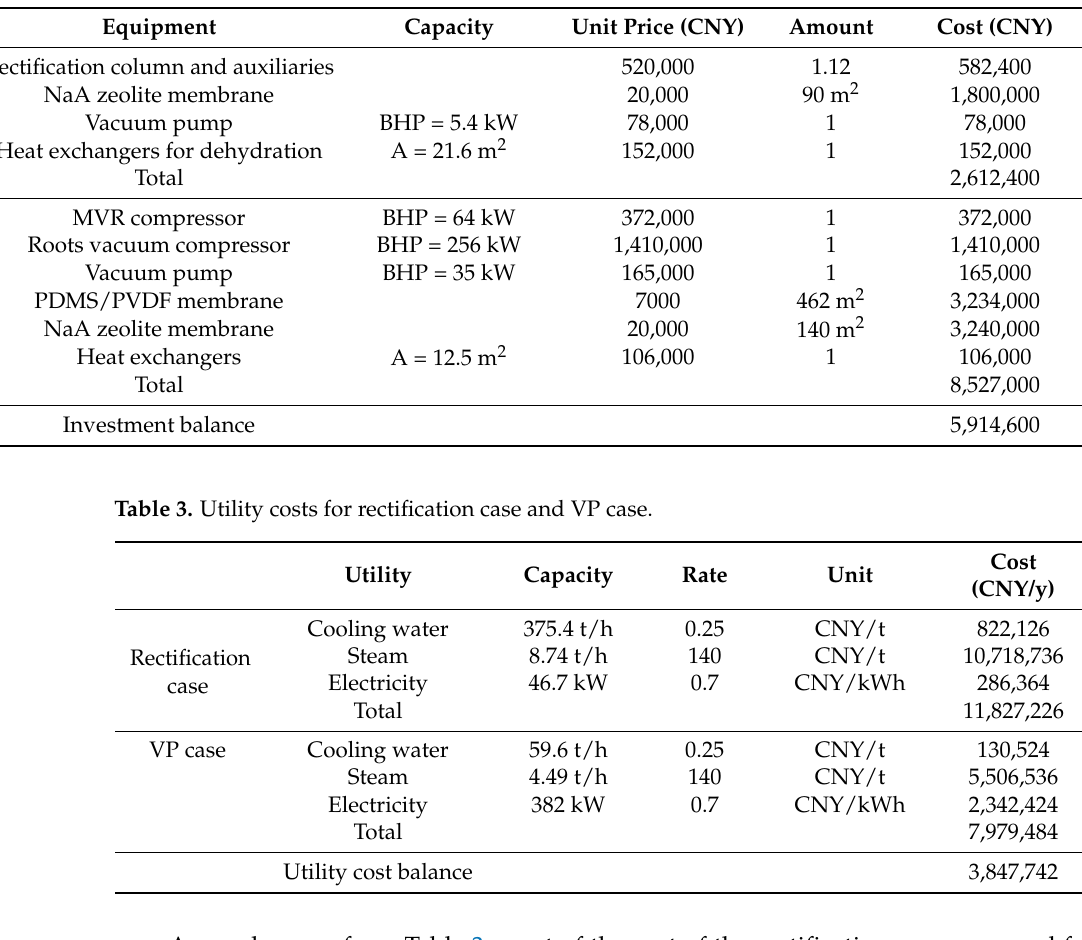
Table 2. Purchased equipment costs for rectification case and VP case.